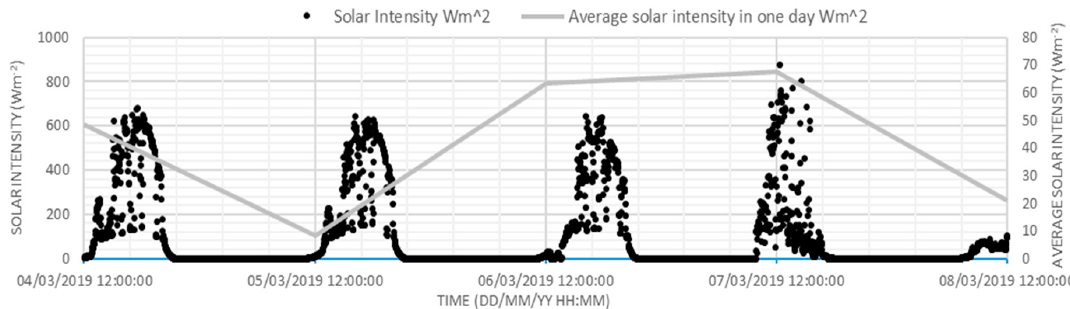
Figure 7. Measured solar intensity in the first week.